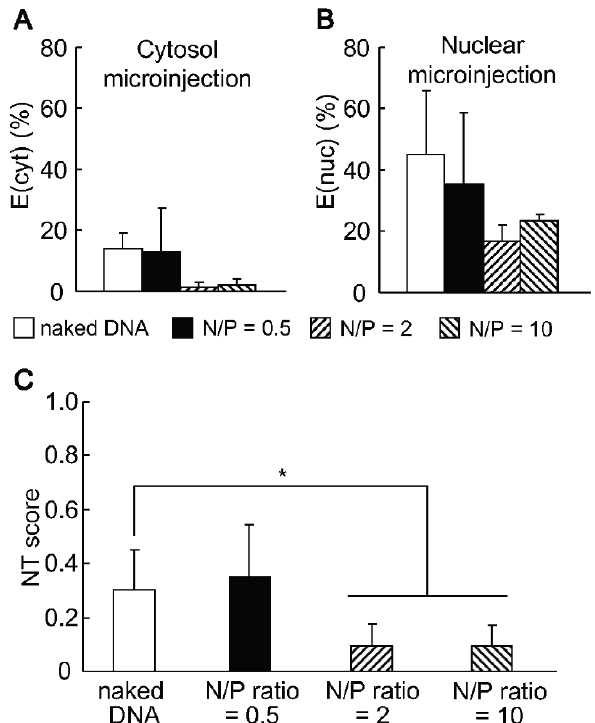
Figure 2. EGFP expression after the cytoplasmic and nuclear microinjection of protamine/DNA complexes. The minicircle DNA (MC07.CMV-EGFP) was compacted with protamine